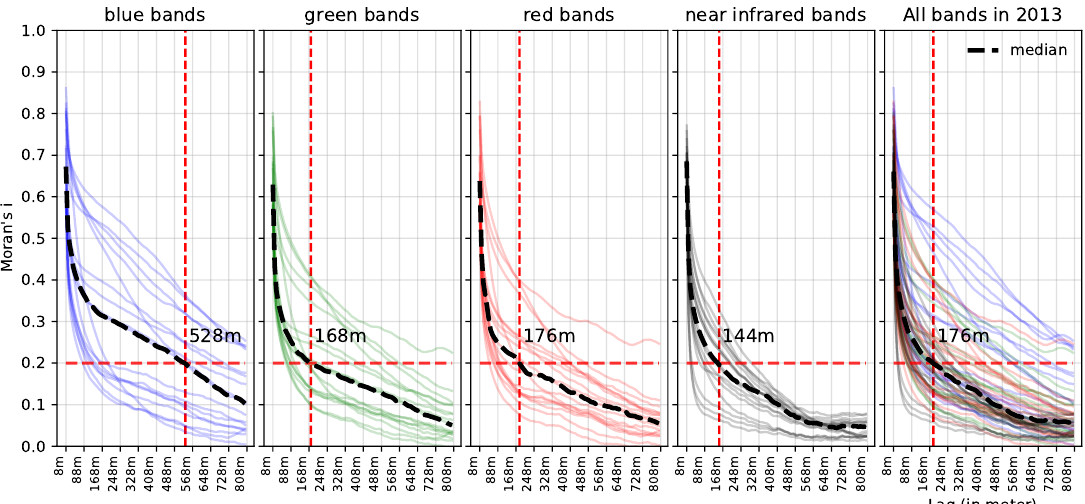
Figure 5. Moran’s I correlograms of each Formosat-2 spectral band of the Satellite Image Time Series (SITS) 2013, for pixels representing forests. Each curve represents one date of the SITS. the red dashed line represents the median distance value (in x) where Moran’s I = 0.2 (in y). For a Moran’s I thresold value of 0.2, spatial independence between nearby pixels was assumed. This is the case beyond to 528 m in the blue band, 168 m in the green, 176 m in the red and 144 m in the